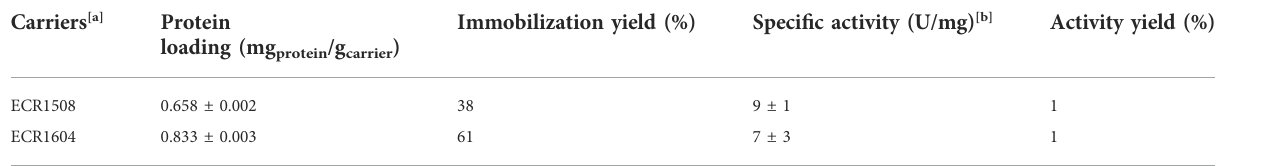
TABLE 2 Screening results obtained for the ionic immobilization of Aae UPO PaDa-I. Carriers [a]